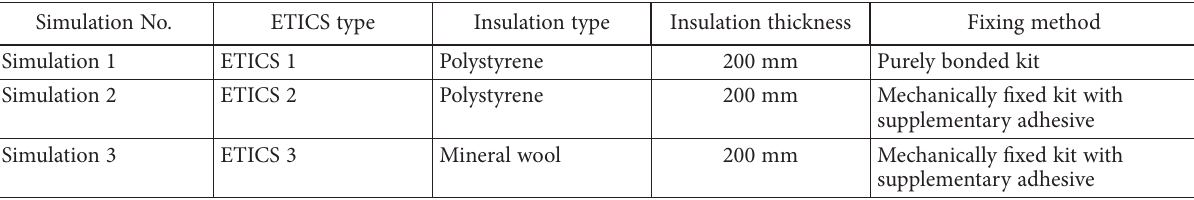
Table 3. Characteristics of simulations